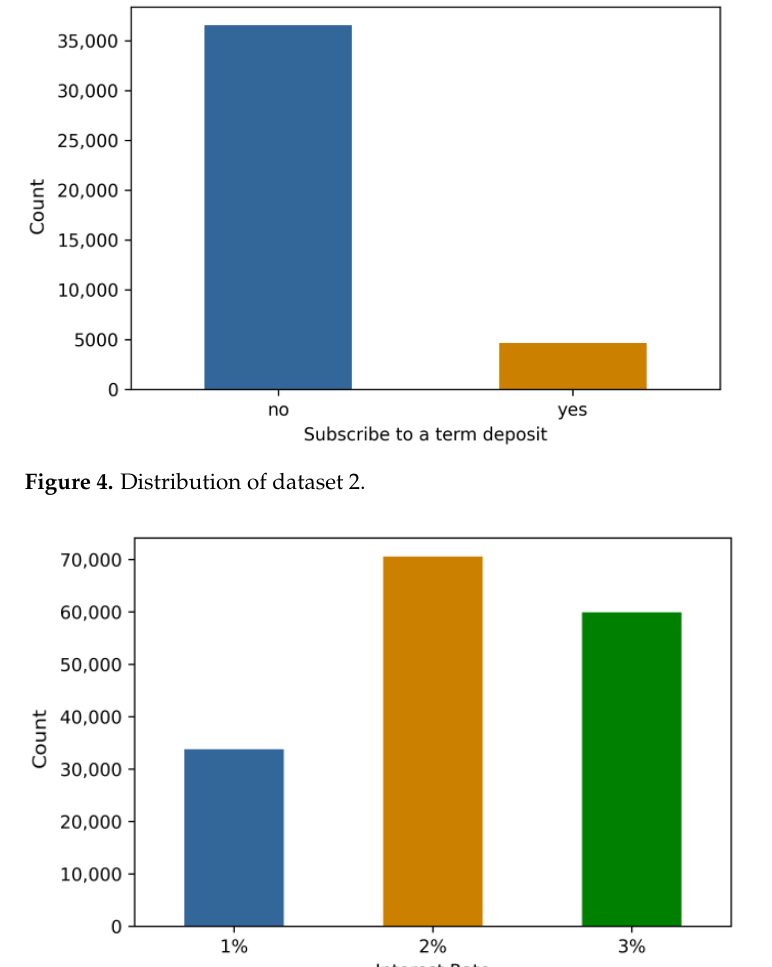
Figure 3. Distribution of dataset 1